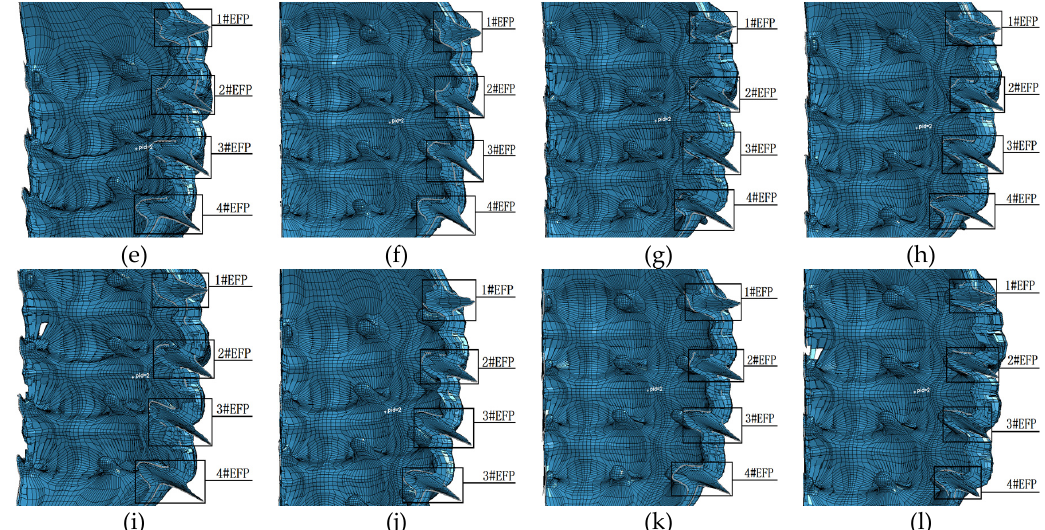
Figure 8. 1#EFP-4#EFP formed shape of the liner which different curvature radius of outer wall and different center thickness:( a ) R1 = 10 mm, R2 = 6 mm, ∆ t = 1.0 mm; ( b ) R1 = 10 mm, R2 = 7 mm, ∆ t = 1.0 mm; ( c ) R1 = 10 mm, R2 = 9 mm, ∆ t = 1.0 mm; ( d ) R1 = R2 = 10 mm, ∆ t = 1.0 mm;